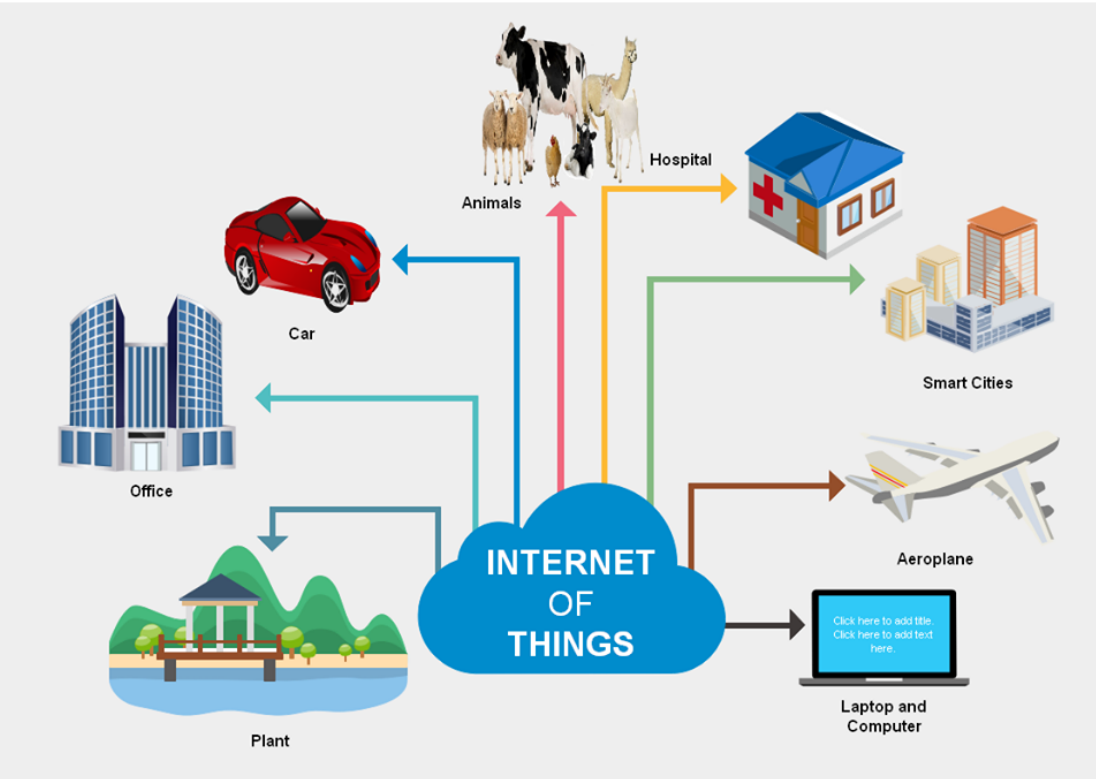
Figure 1. Application domains of